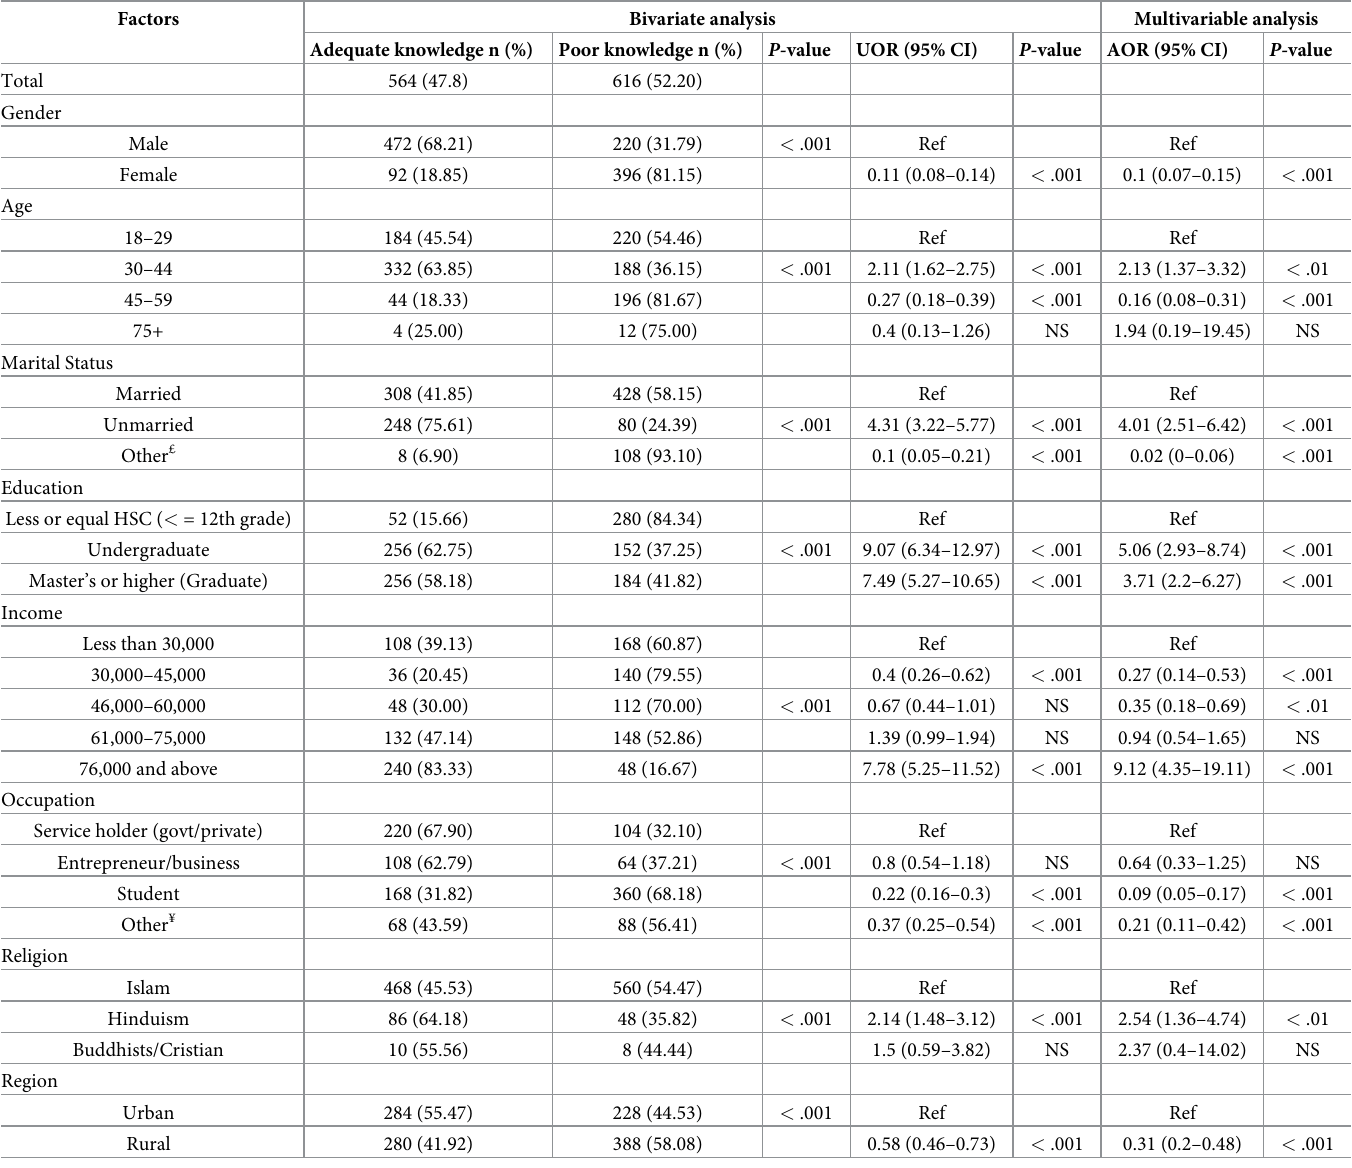
Table 3. Associated factors with knowledge of TB among